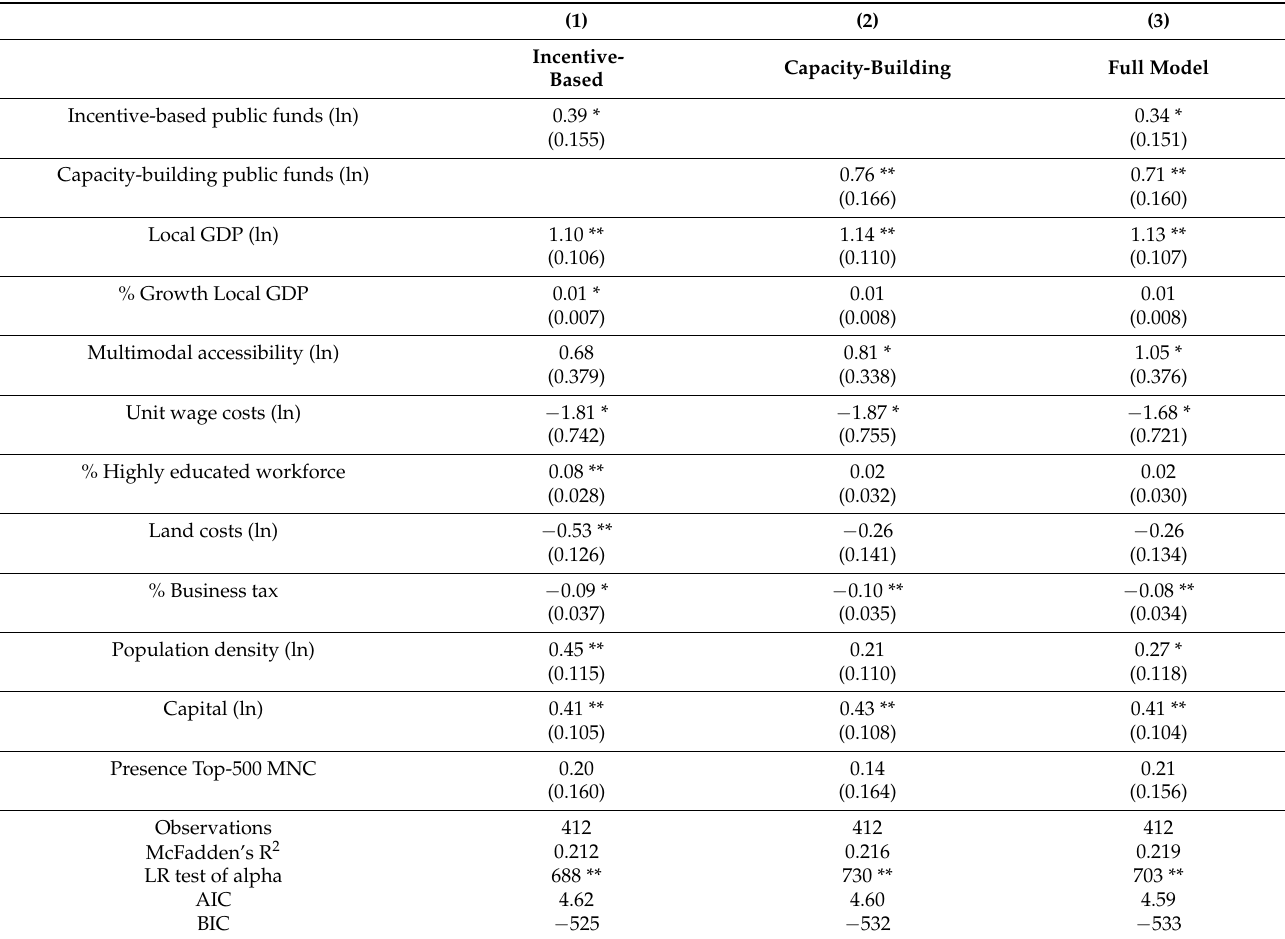
Table A2. Negative Binomial Estimations on Number of Greenfield FDI: Incentive-Based versus Capacity-Building